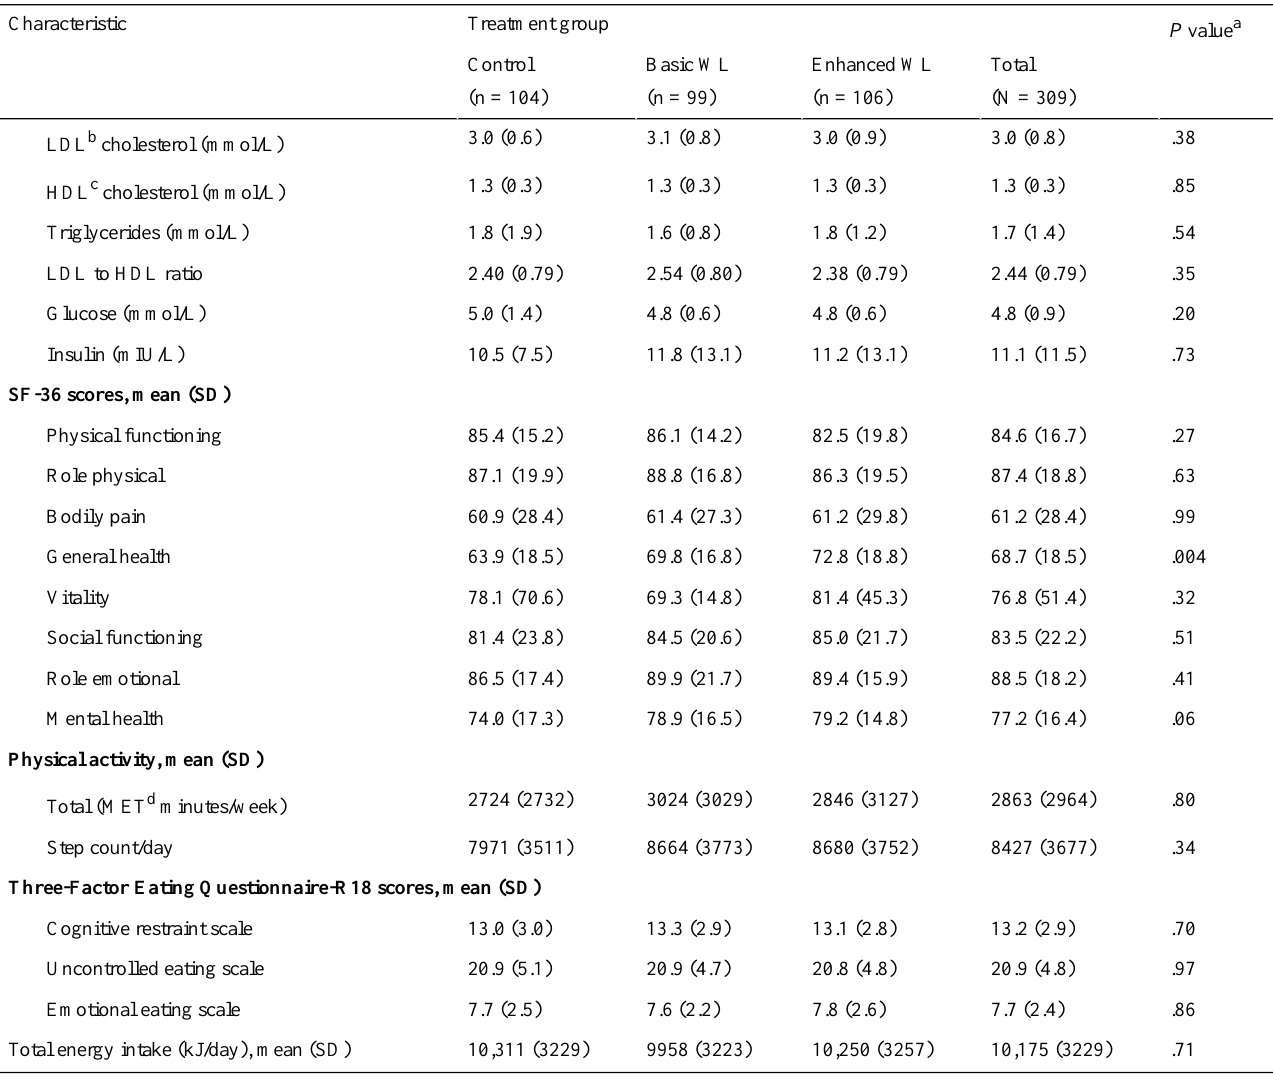
a P values are from analysis of variance for continuous measures and from a chi-square test for categorical measures. b Low-density lipoprotein. c High-density